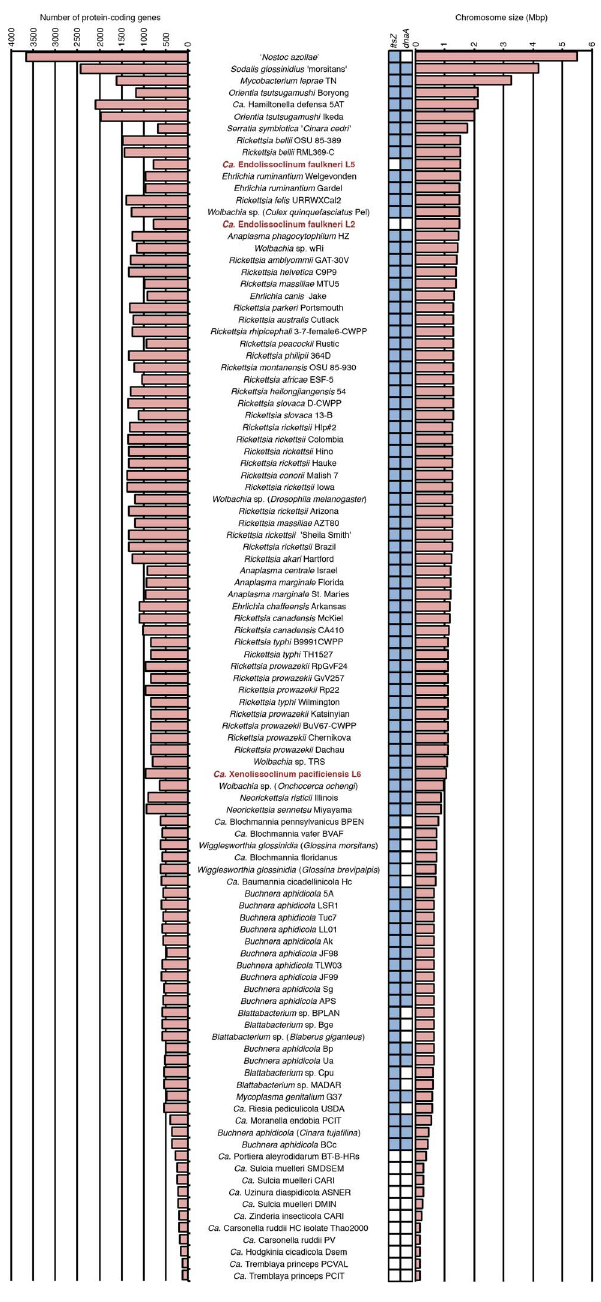
Figure 9. Ca. E. faulkneri strains have low coding density and possess the largest genomes lacking ftsZ , and Ca. E. faulkneri L2 has the largest genome also lacking dnaA . A set of symbionts and pathogens that live intracellularly and/or show signs of genome reduction are shown, in descending order of genome size. Shaded blue squares indicate the presence of ftsZ or dnaA . Note: All genomes included above are completed except for Ca. X. pacificiensis where the genome size plotted reflects the sum of contig sizes in the draft genome.